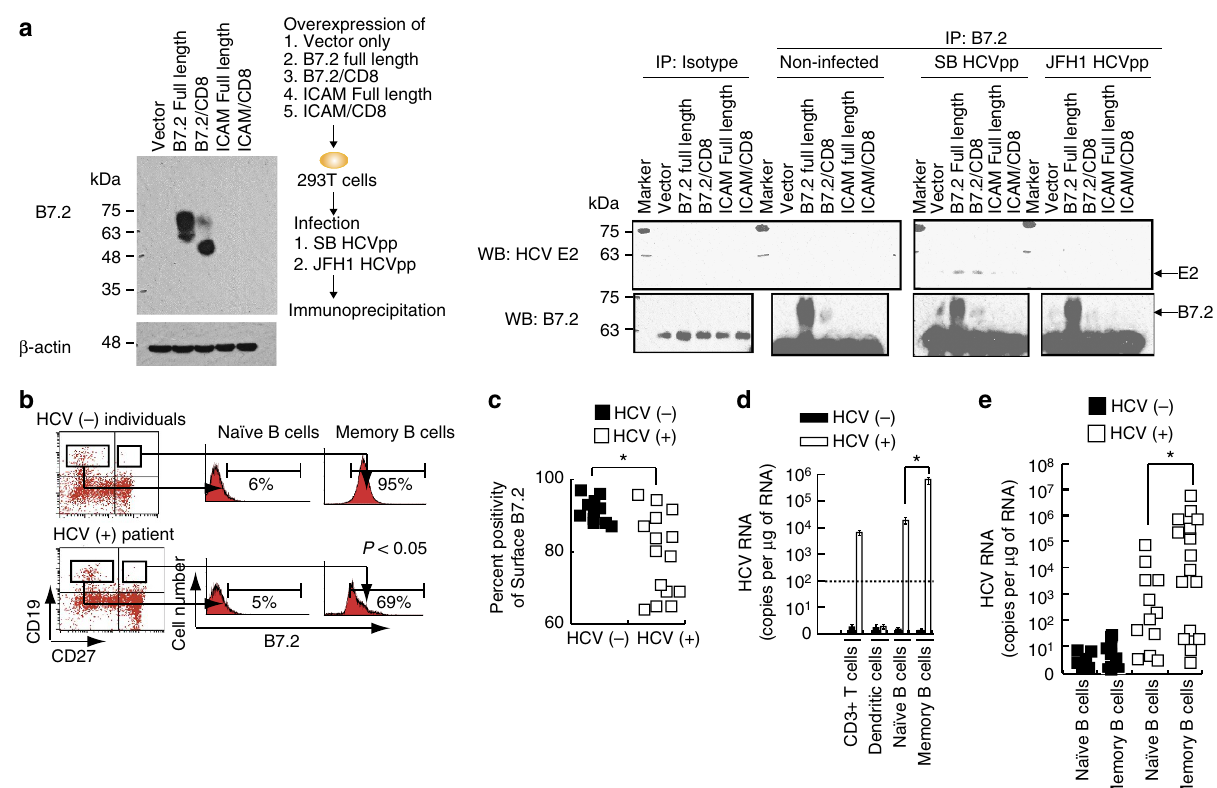
Figure 6 | Envelope protein E2 of HCV SB strain interacts with B7.2 protein in shRIGI-Raji cells and surface B7.2 is reduced in memory B cells of HCV patients. ( a ) Envelope protein E2 of HCV SB strain interacted with B7.2 protein in shRIGI-Raji cells. Arrows indicate bands of HCV E2. ( b ) B cells from healthy individuals (upper panel) and HCVpatients (lower panel) were sorted by flow cytometry into CD19 þ CD27- naı¨ve B cells or CD19 þ CD27 þ memory B cells. The former expressed a low level of B7.2, whereas the latter expressed a high level of B7.2. ( c ) Surface B7.2 expression is reduced in human memory B cells in HCV patients. Human patient B cells were sorted into two fractions, naı¨ve B cells (CD19 þ /CD27 (cid:2) ) and memory B (CD19 þ /CD27 þ ), and used for RNA isolation. ( d , e ) Memory B cells were infected with HCV. Human memory B cells showed higher levels of HCV RNA in clinical specimens (* P o 0.05, t -test, n ¼ 3). Error bars represent s.d. Analysis of HCV RNA in B cells, T cells, monocytes and dendritic